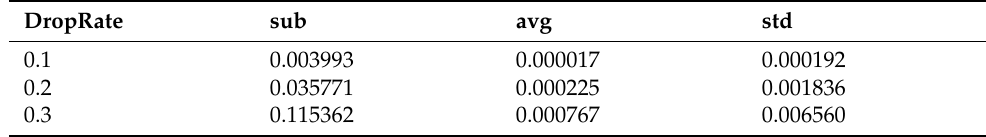
Table 1. Related error results under different drop rates on real data.